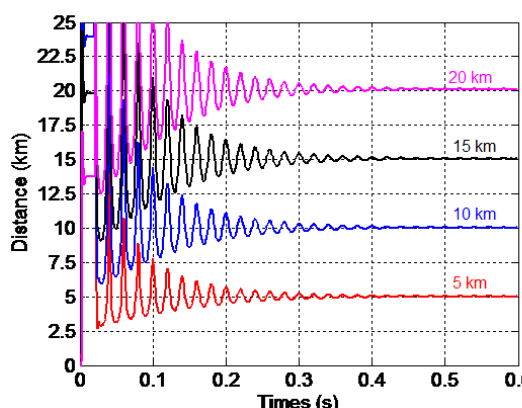
to 0.062 sec, it’s late by 2 ms.